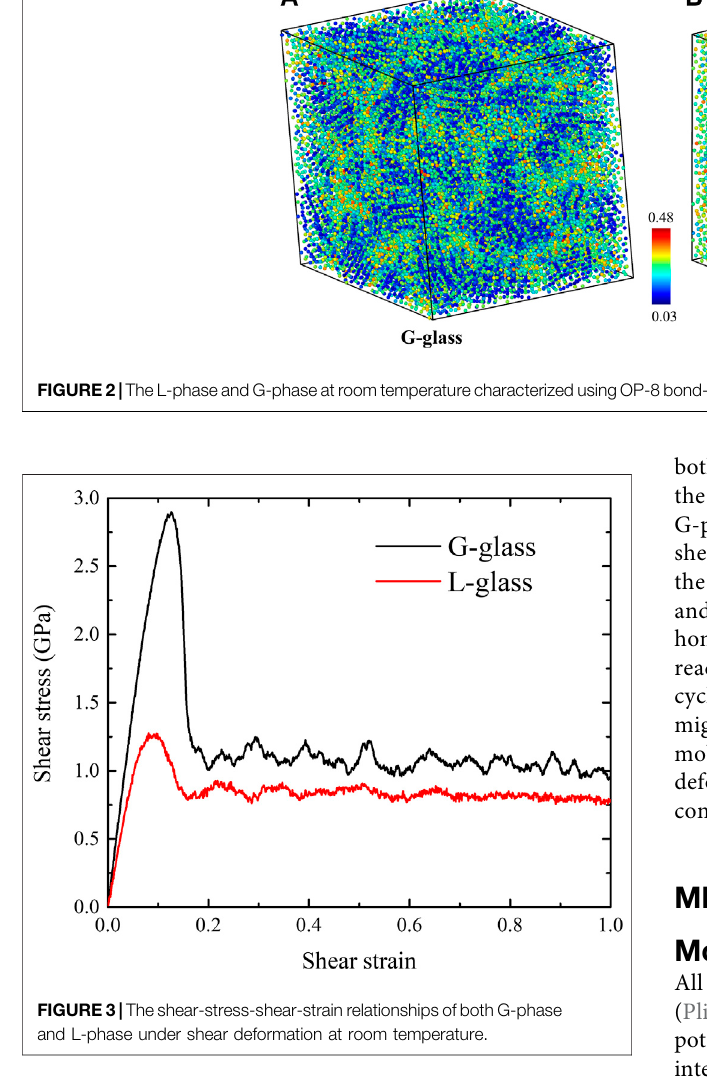
Frontiers in Materials |